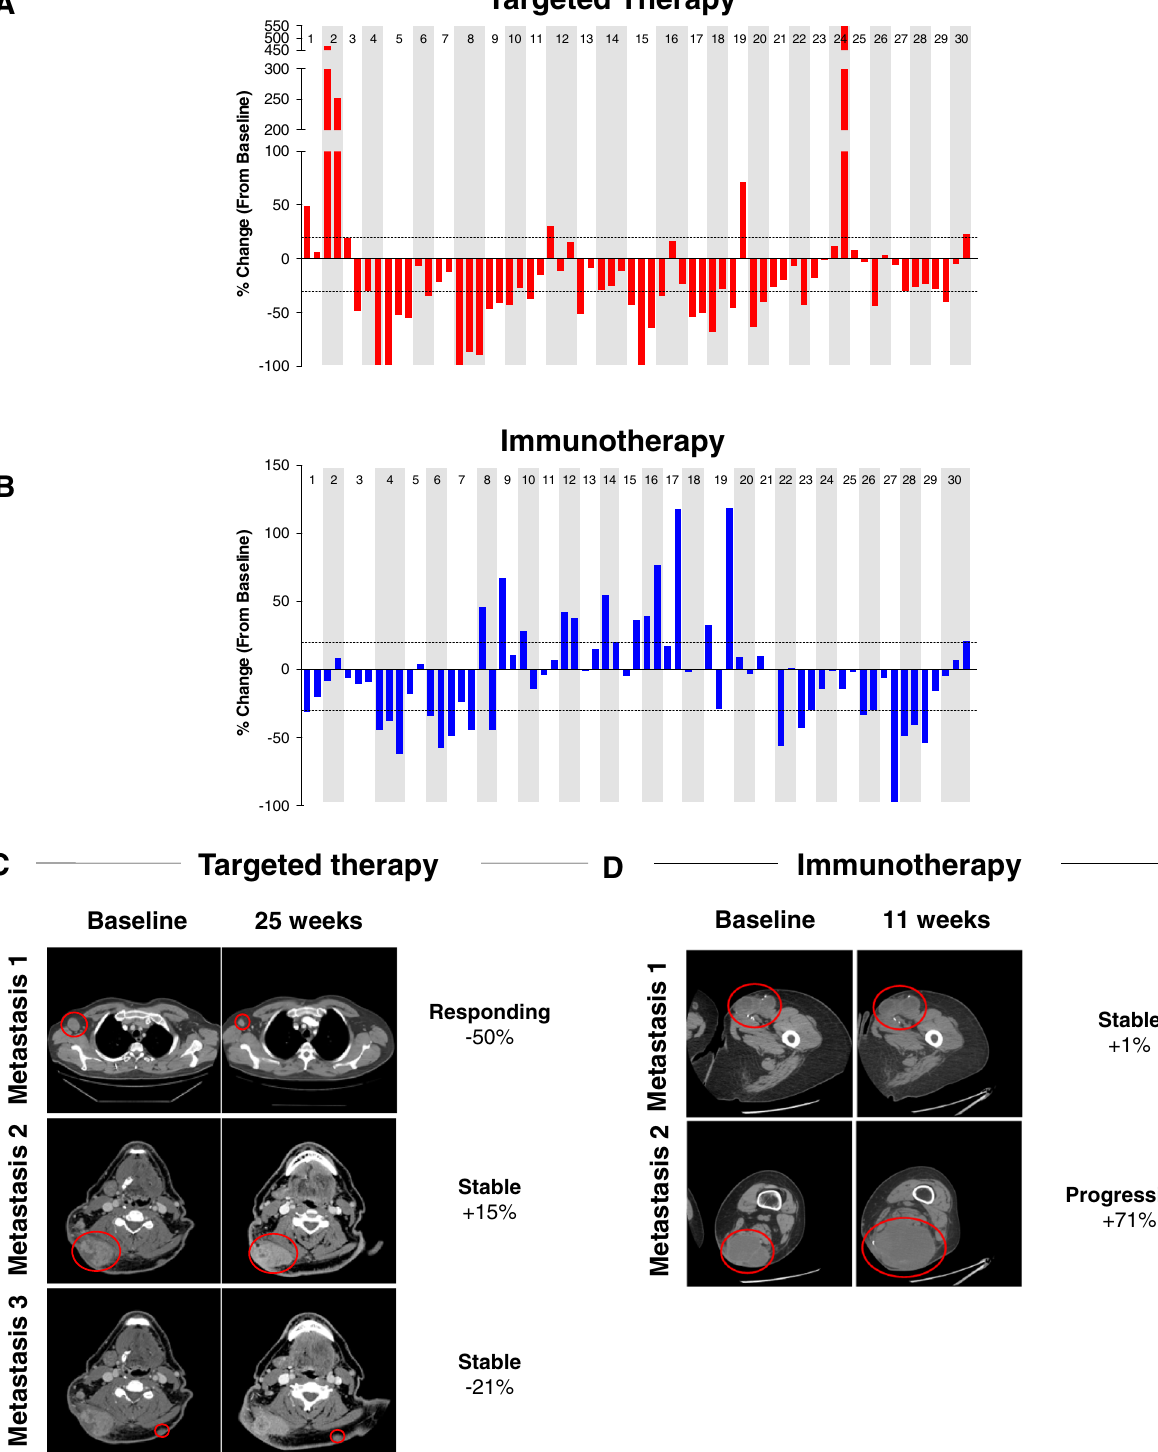
Fig. 1 Differential intrapatient responses to targeted therapy and immune checkpoint blockade are widespread in patients with synchronous melanoma metastases. a Change in tumor size from baseline in a cohort of 30 patients with synchronous melanoma metastases treated with BRAF/MEK-inhibitor combination fi rst-line therapy. b Change in tumor size from baseline in a cohort of 30 patients with synchronous melanoma metastases treated with PD-1 checkpoint blockade fi rst-line therapy. Representative CT scans showing differential intrapatient responses to therapy in two patients treated with c BRAF-inhibitor therapy and d PD-1